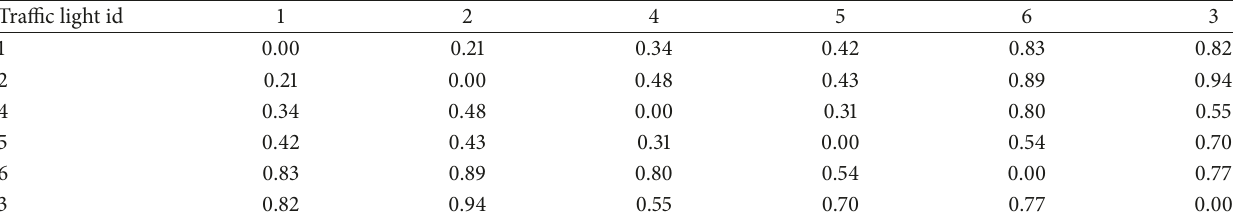
Table 10: Total variation distances for comparing each pair of traffic